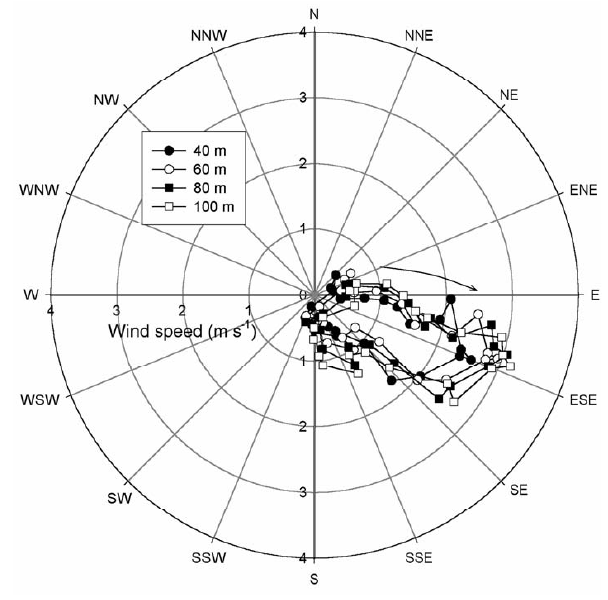
Fig. 6. Anti-cyclonic rotation of the hourly average wind speed in the first four levels.